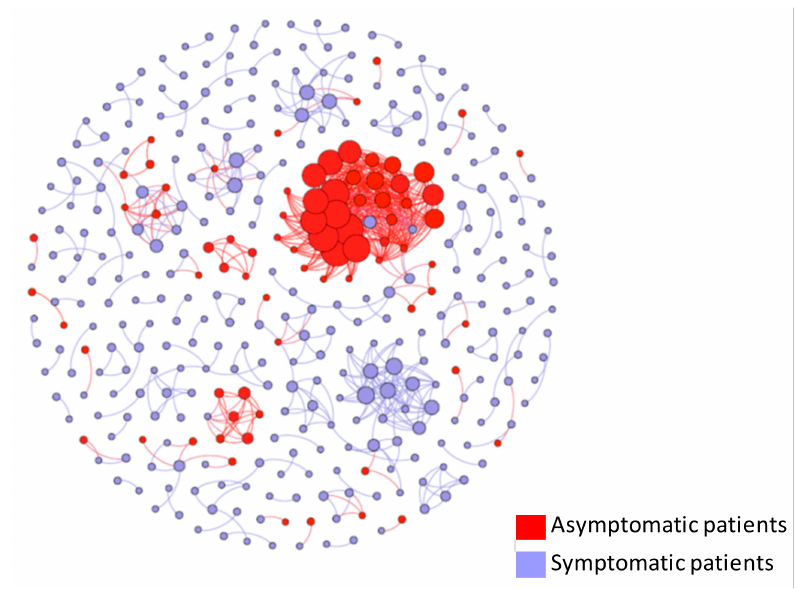
Figure 6. Viral transmission networks by asymptomatic status.